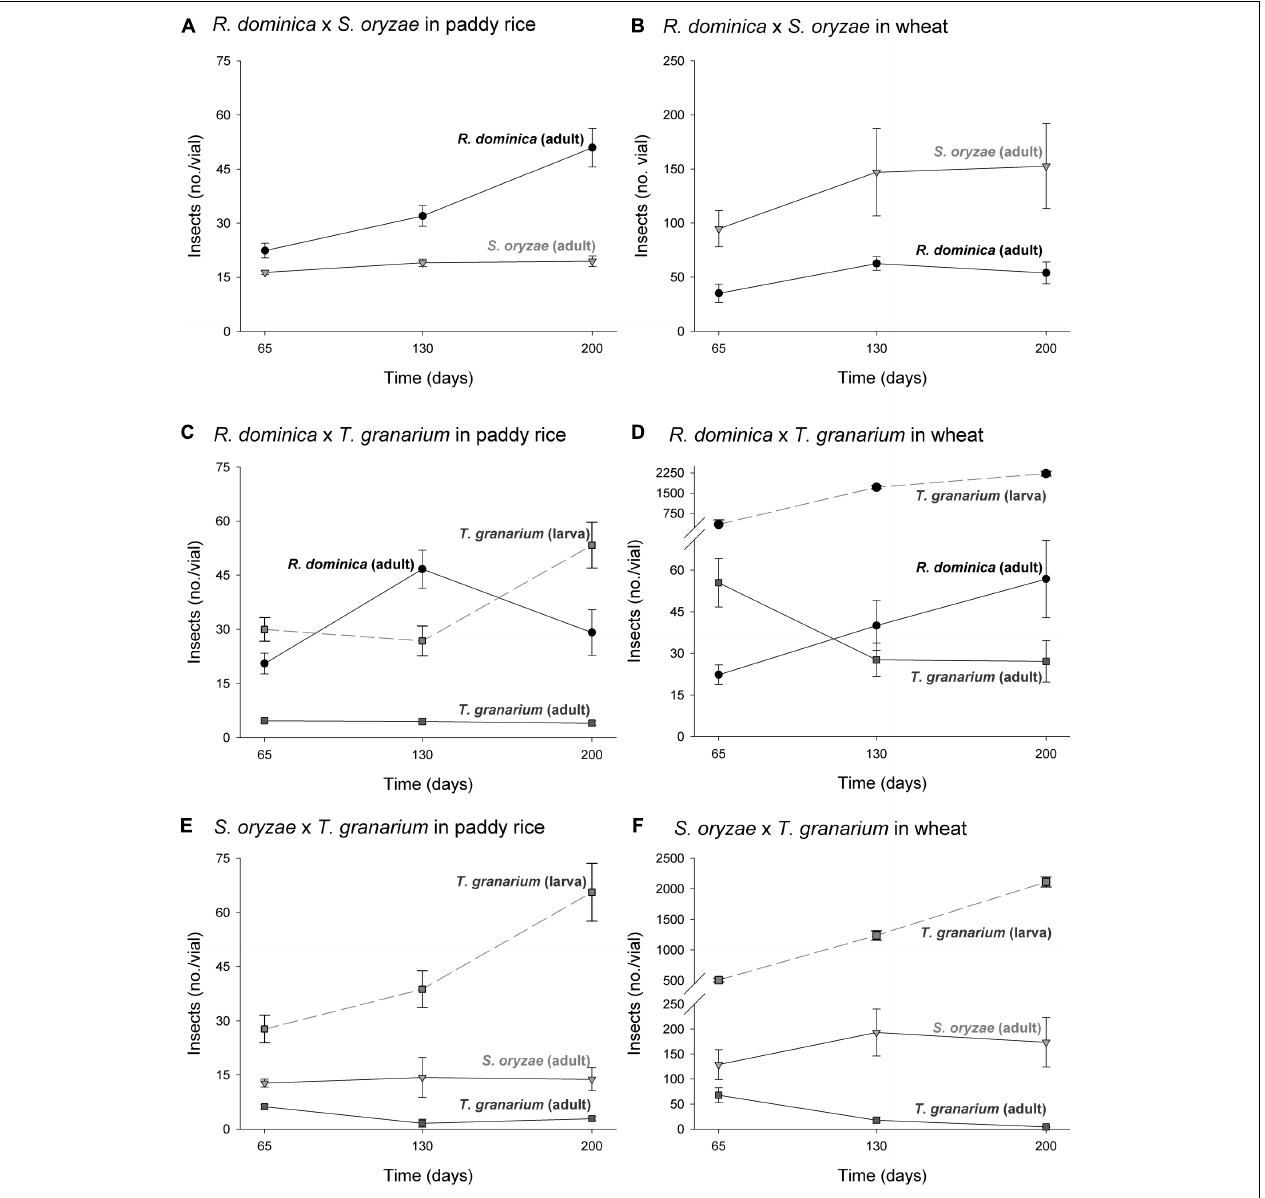
FIGURE 4 | Increase in insect populations under two-species competition through time in grains of two cereal host species, paddy rice and wheat. The symbols indicate the average of nine replicates and the vertical bars represent standard errors of the mean. The labels (A–F) refer to each binary group of competing species in two host grains, i.e., paddy rice (A,C,E) and wheat (B,D,F)